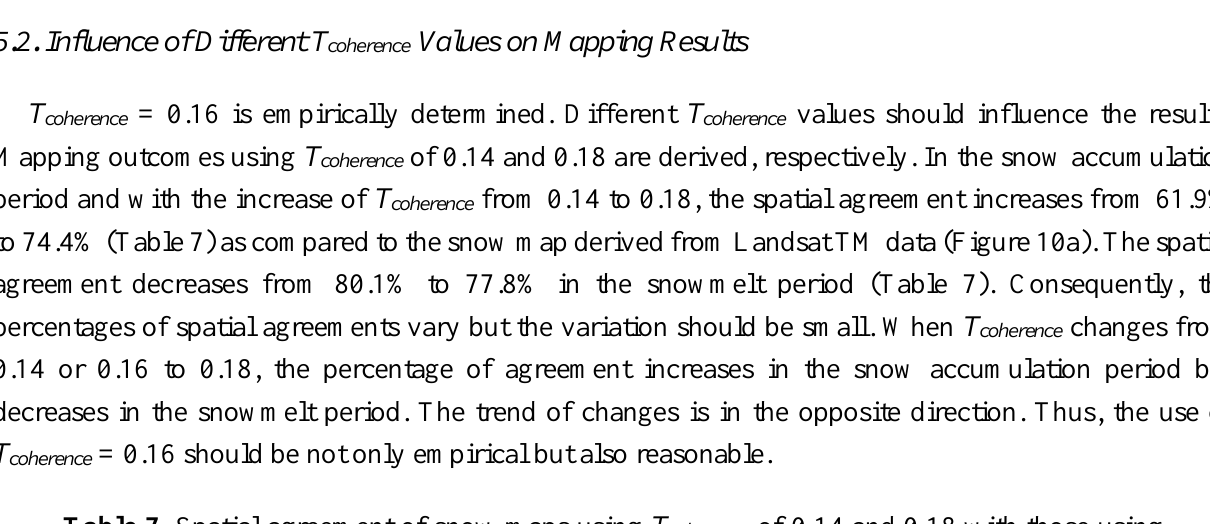
Table 7. Spatial agreement of snow maps using T coherence of 0.14 and 0.18 with those using Landsat 5 TM data in snow accumulation and snowmelt